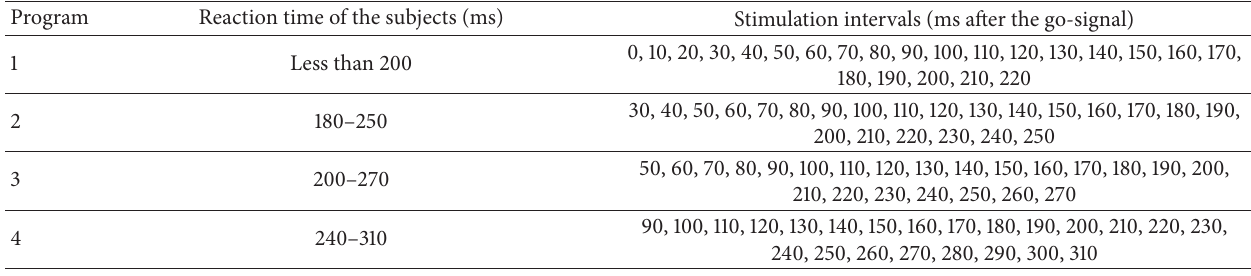
Table 2: Stimulation protocol.